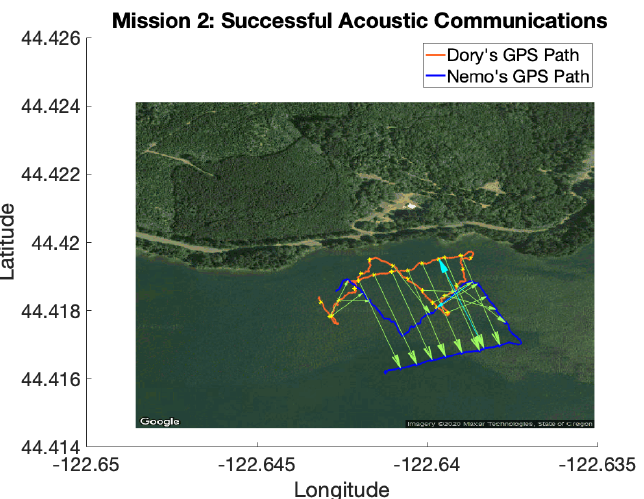
Figure 6. Successful acoustic communications between the uUUVs. The green arows indicate communications from Dory to Nemo and the Cyan arrows show communications from Nemo to Dory. Note that Dory was much more successful at communicating to